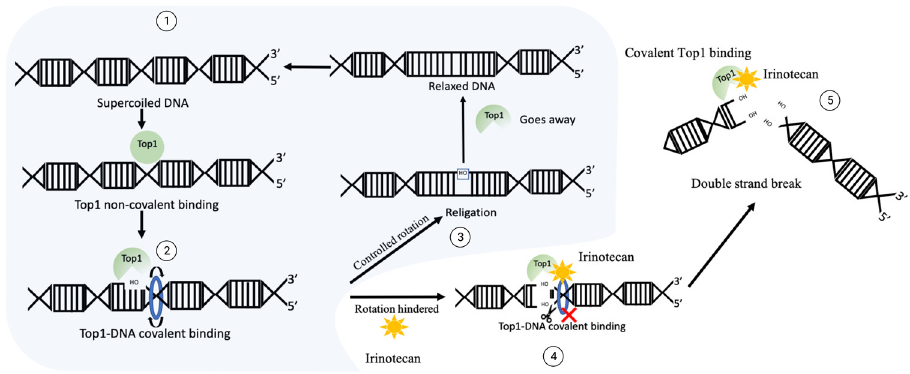
Figure 1. The mechanism of DNA generation breaks upon irinotecan exposure. Normal function of Top1: ① supercoiled sensing and nick development by Top1 leads to ② relaxation, then ③ Top1 re-ligates the nicked backbone and leaves the site. In the case of irinotecan exposure, Top1 gets covalently crosslinked to DNA, then ④ ligation of 3 ′ -OH free end is blocked, which could translate into ⑤ double strand break and facilitate cytotoxicity.